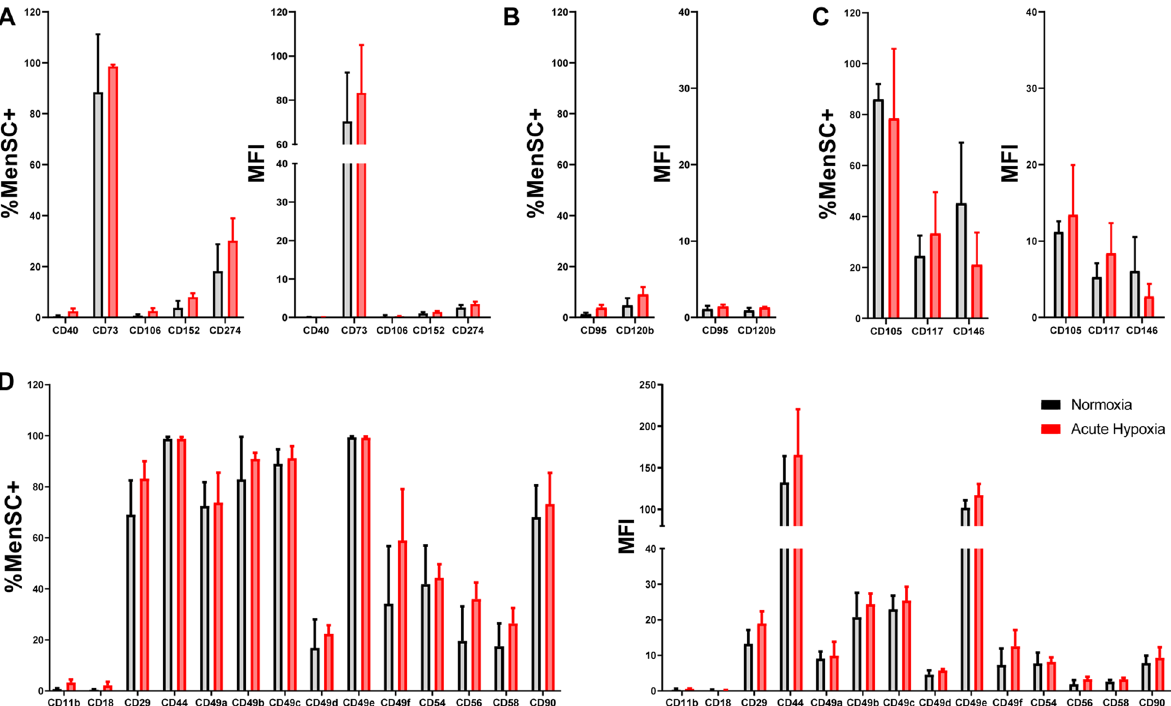
Fig. 1 Expression of phenotypic surface markers on MenSCs. Analysis of surface markers of MenSCs under acute hypoxia (red bars, n Graph bars show the percentage of positive MenSCs and the mean fluorescence intensity (MFI) of the different surface markers A immune‑related markers, B apoptosis‑related markers, C angiogenesis‑related markers, and D cell adhesion/migration‑related markers. A paired t‑test was performed to compare acute hypoxia with normoxia. A p < 0.05 was considered statistically